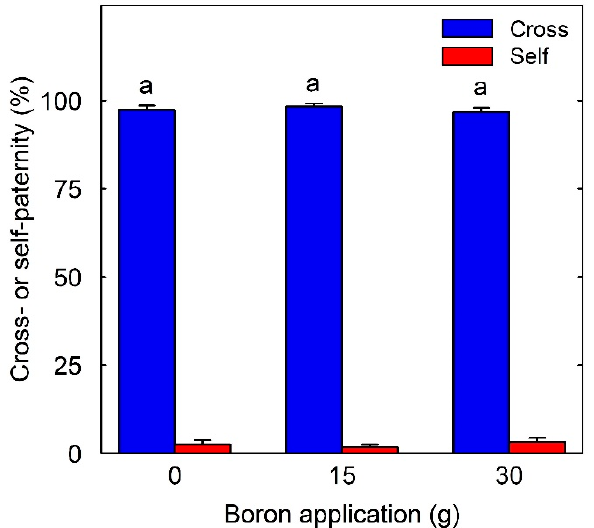
Figure 4. Levels of cross- and self-paternity among nuts of macadamia cultivar ‘816’ trees treated with 0, 15 or 30 g B prior to flowering. Means (+SE) do not differ significantly among B treatments (generalised linear model, p > 0.05, n = 10 trees).